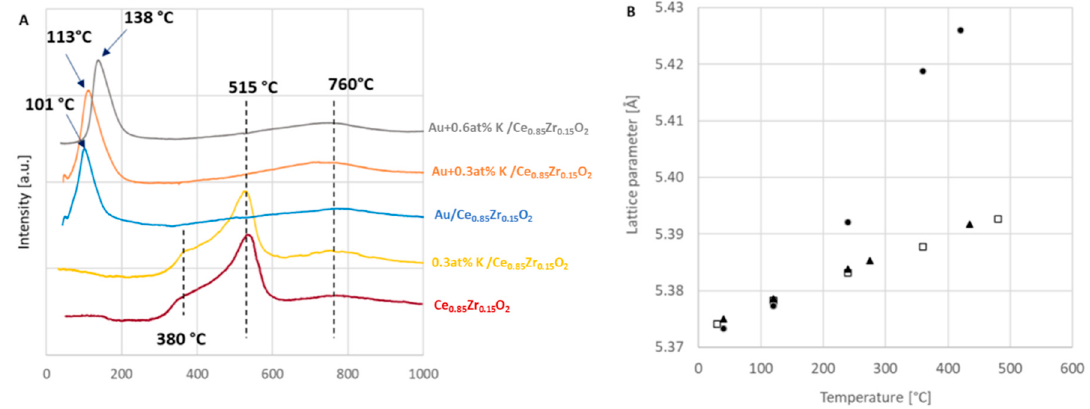
Figure 4. Results of ( A ) Temperature Programmed Reduction experiments and ( B ) in situ X-ray Diffraction studies of the Au + 0.3 at% K/support system in three different atmospheres: H 2 (spheres), O 2 (squares), and He (triangles).